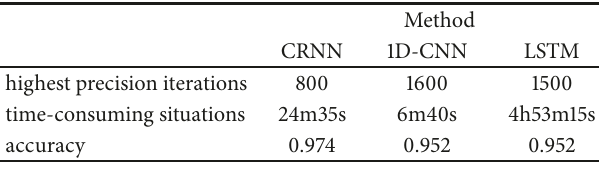
Table 6: Comparison of the time-consuming conditions and accu- racy between CRNN, 1D-CNN, and LSTM.